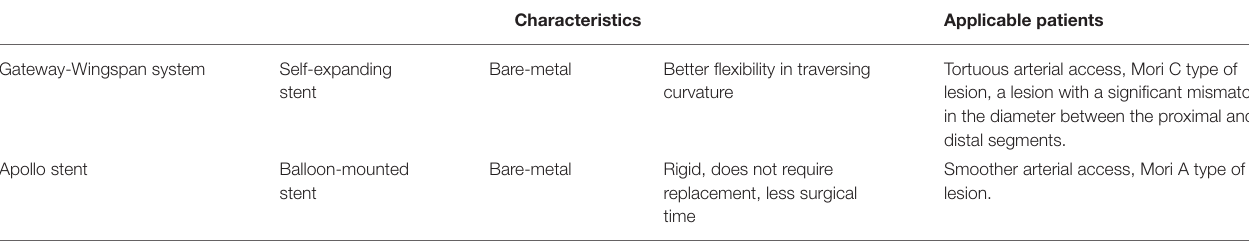
TABLE 1 | Comparation between the Gateway-Wingspan system and the Apollo